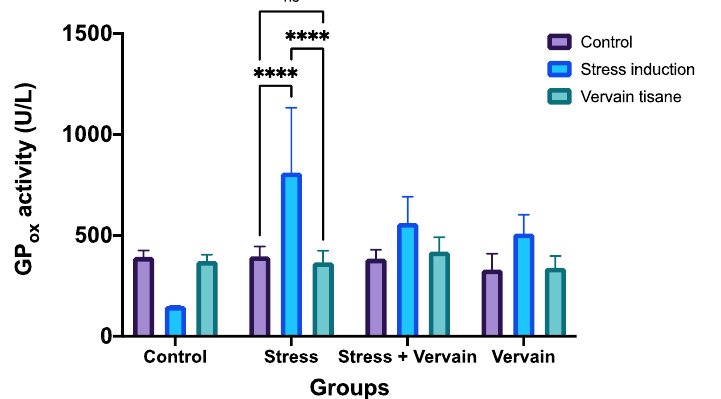
Figure 7. Quantitative determination of glutathione peroxidase (GP ox ) concentration in whole blood. ****— p < 0.0001; ns — non-significant.